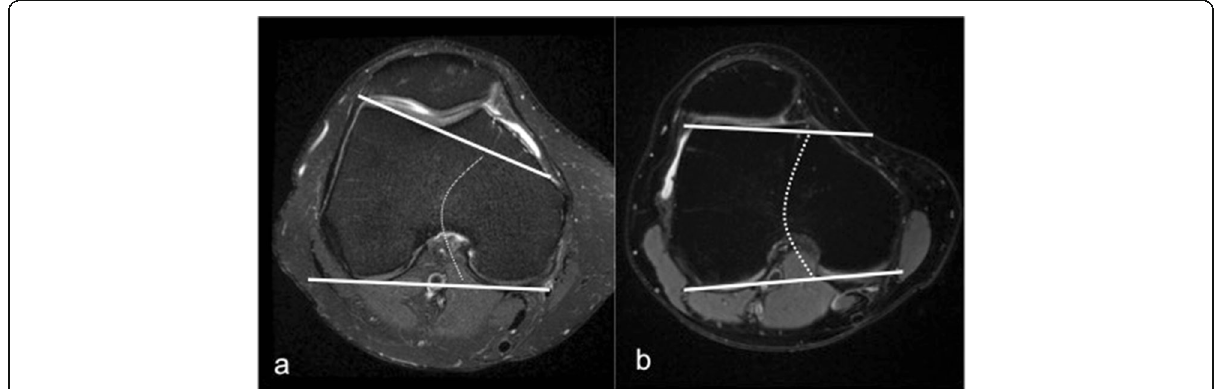
Fig. 2 Lateral trochlear inclination measurement on axial MRI. It is the angle between a line tangential to the subchondral bone of the posterior aspect of the femoral condyles and a line along the lateral trochlear facet. a Normal trochlea. b Trochlear dysplasia (9°